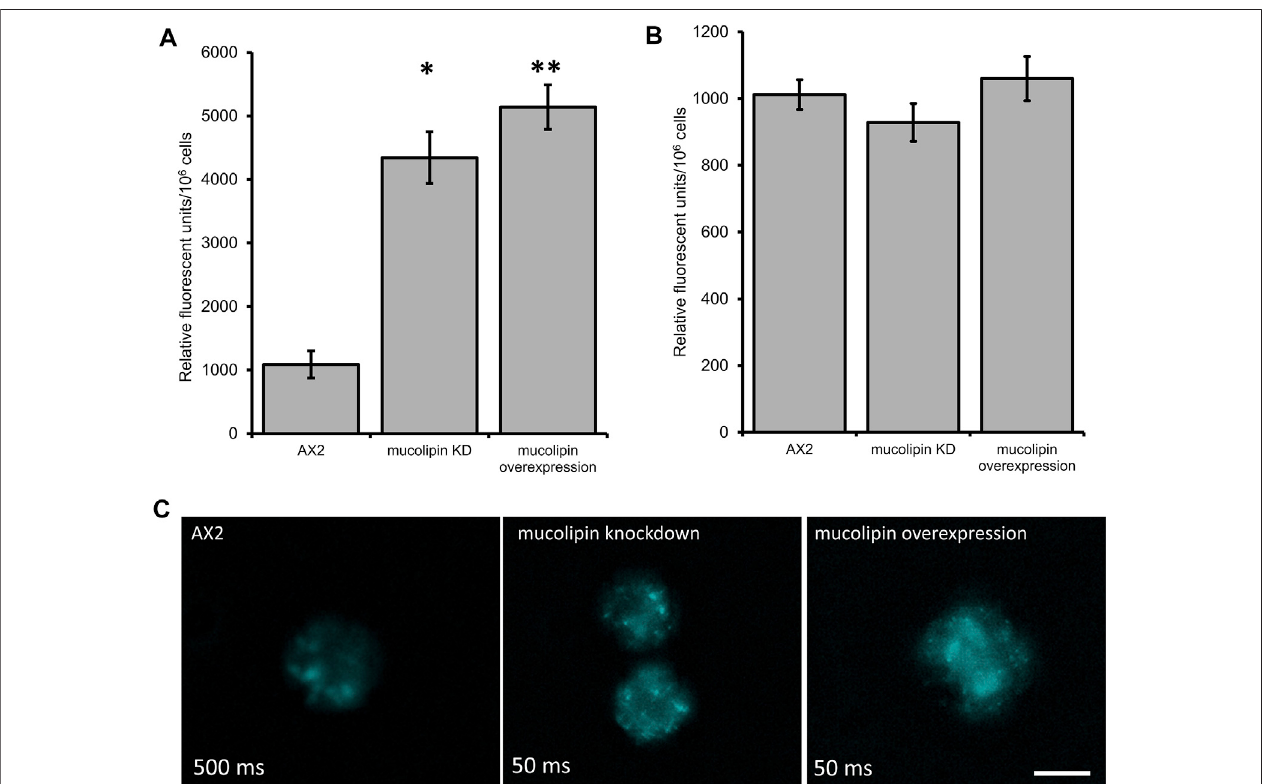
FIGURE5| Alteringmucolipinexpressioncausesaccumulationorincreasedacidi fi cationofvesiclesstainedwithLysoSensor TM BlueDND-167butdoesnotcause auto fl uorescence. (A) Quanti fi cation of LysoSensor ™ Blue DND-167 was performed by measuring the increase in fl uorescence in 1 × 10 6 vegetative cells after incubation with 500 nM LysoSensor ™ Blue DND-167. Datawas collected from seven knockdown strains and sixoverexpression strains in three individual